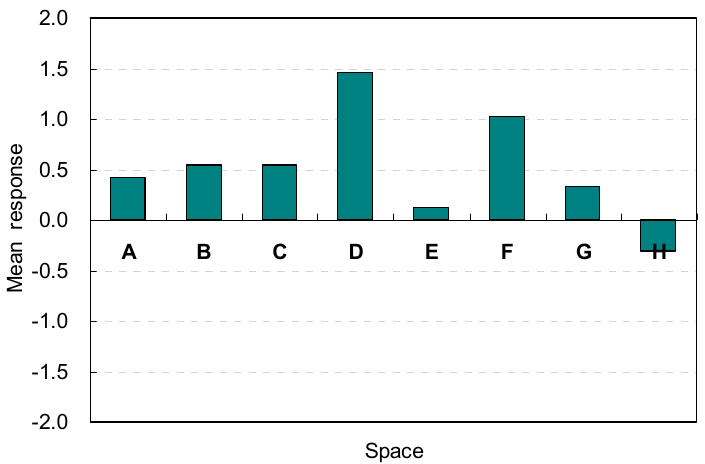
Figure 18. Overall satisfaction of the space in terms of efficiency.